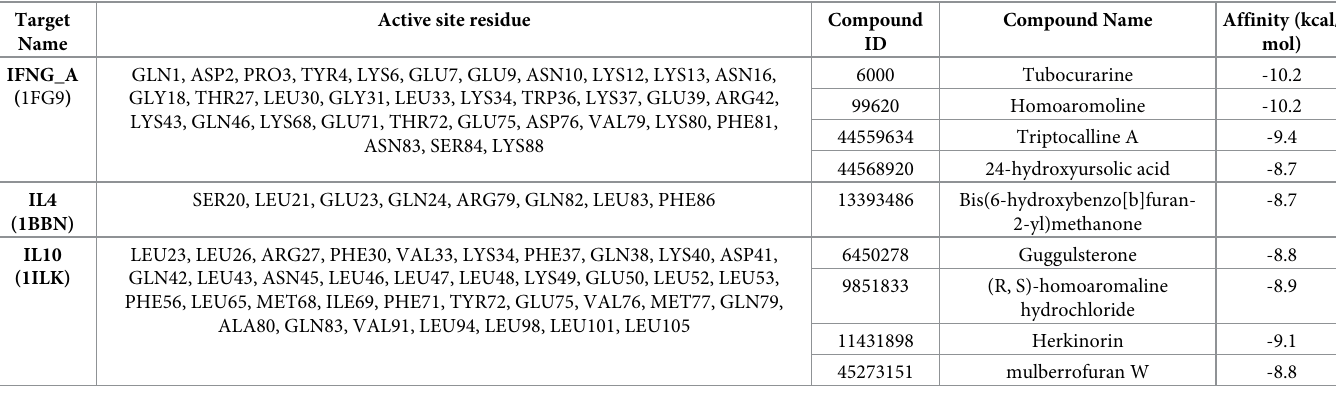
Table 4. Binding affinity scores for top protein-ligand